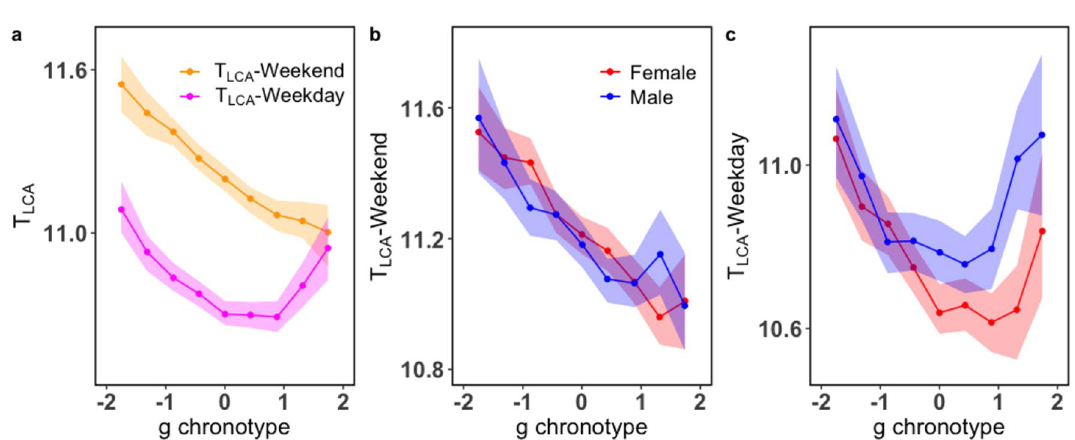
Figure 8. Period of low calling activity of users of different chronotypes: ( a ) The period of low calling activity T d LCA is the width of the region between the activity modes, calculated according to Eq. (2) for different days ( d ) of the Weekend and weekdays T LCA Weekday is plotted as a function week. The average of T d LCA on weekends T LCA − − Weekday of the general (g) chronotype in orange and magenta, respectively. ( b ) T LCA –Weekend and ( c ) T LCA − Weekend and are plotted as a function of the chronotype for both genders. For each chronotype, T LCA − T LCA Weekday has been calculated separately with the shaded regions in all three plots representing the bootstrap − 95% confidence intervals. The red plot is for females and blue for males in both ( b ) and ( c